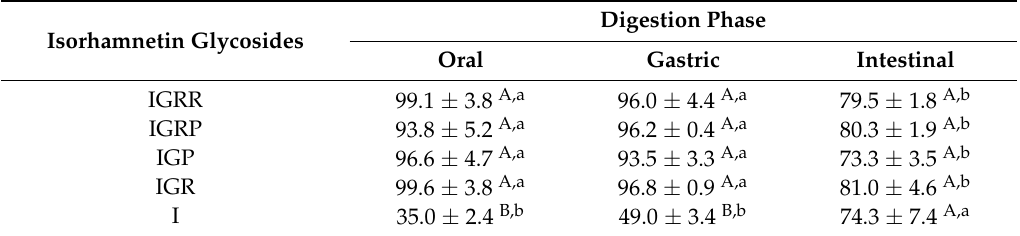
IGRR: isorhamnetin-3- O -glucosyl-rhamnosyl-rhamnoside; IGRP: isorhamnetin-3- O -glucosyl- rhamnosyl-pentoside; IGP: isorhamnetin-3- O -glucosyl-pentoside; IGR: isorhamnetin-3- O -glucosyl- rhamnoside; I: isorhamnetin. A,B Significant differences of the recovery percentage between the isorhamnetin glycosides in each digestion phase. a,b Significant differences between the values of recovery percentage of each isorhamnetin glycosides between the different digestion phases.